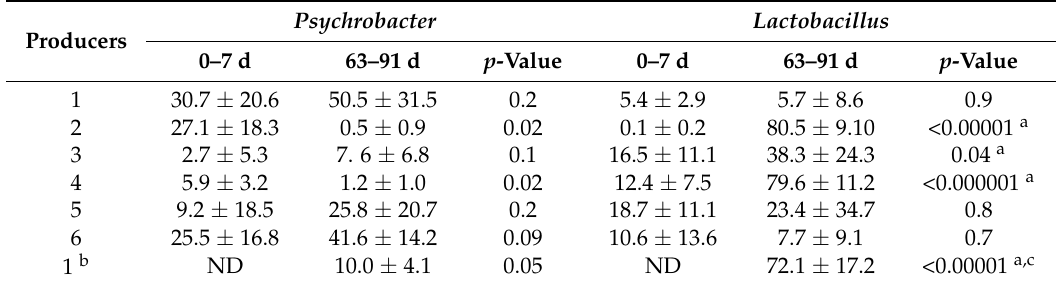
Table 3. The relative amount (% of selected bacteria compared to the total bacterial load) of Psychrobacter and Lactobacillus in samples collected early (days 0–7) and late (days 63–91). Producers